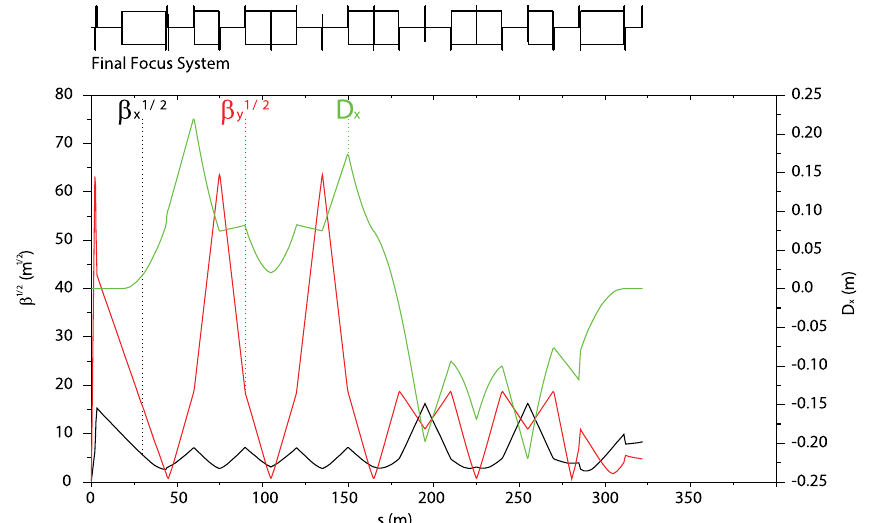
FIG. 12. Lattice functions in a final focusing system with local chromatic compensation section.